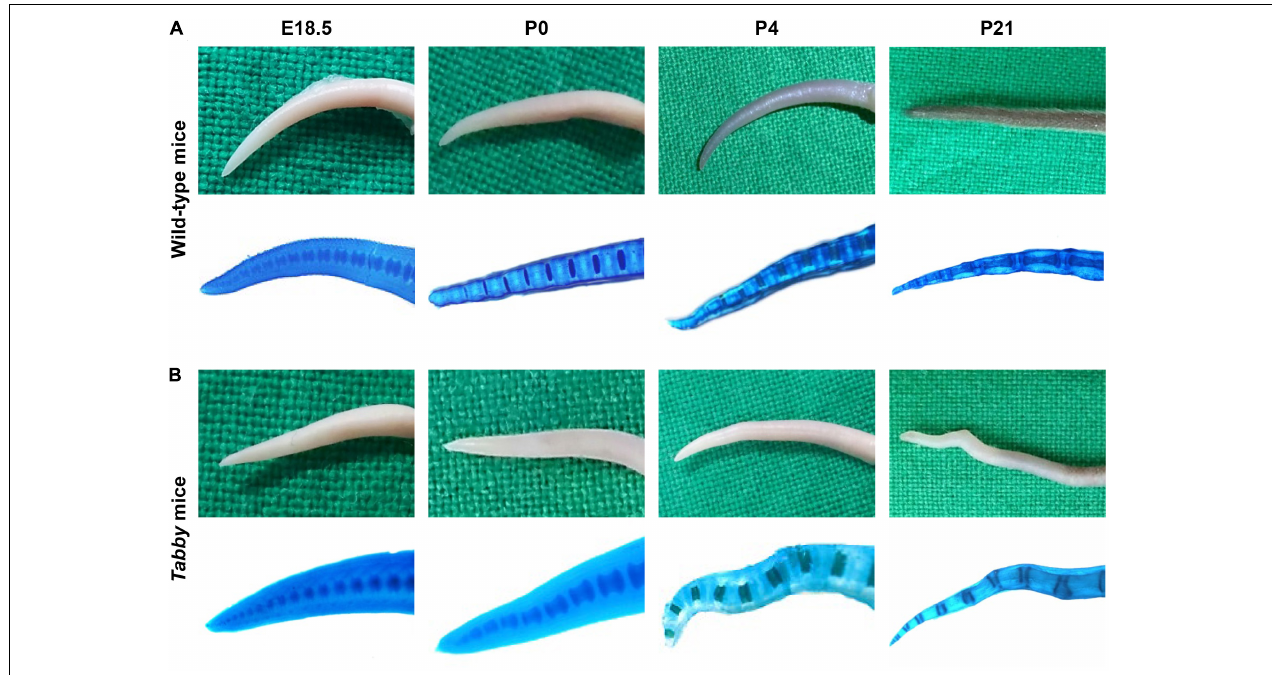
FIGURE 1 | Tabby mice develop vertebral dislocations soon after birth. Macroscopic comparison of representative tail tips from (A) wild-type and (B) untreated Tabby mice at embryonic day E18.5 and postnatal days P0, P4, and P21. Lower panels in panels (A,B) depict whole-mount staining of cartilaginous parts of the same tails with alcian blue. In nearly half of the Tabby mice, first alterations of the distal spine could be detected already on day P4; kinks were evident in 21 of 23 animals investigated at day P21 and in all Tabby mice by day